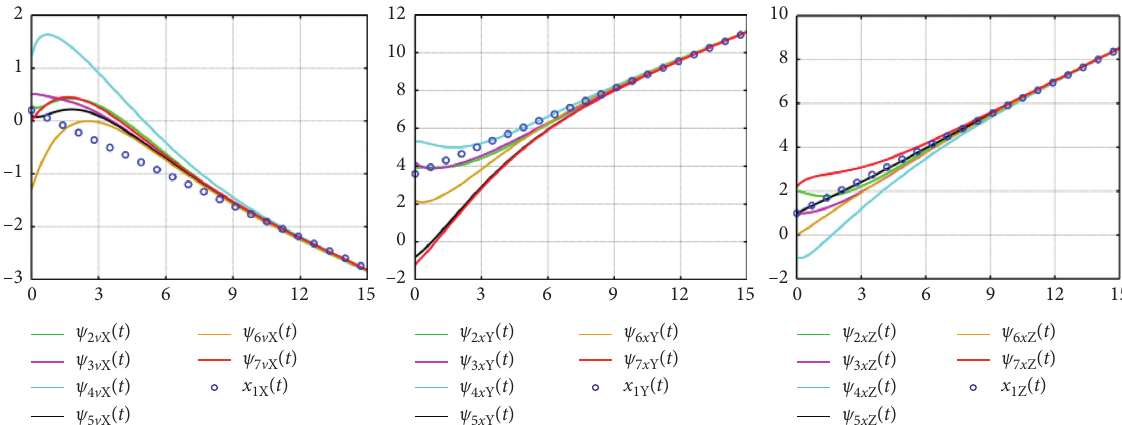
( t )( i � 2 , 3 , . .. , 7 ) in X , Y , and Z ix